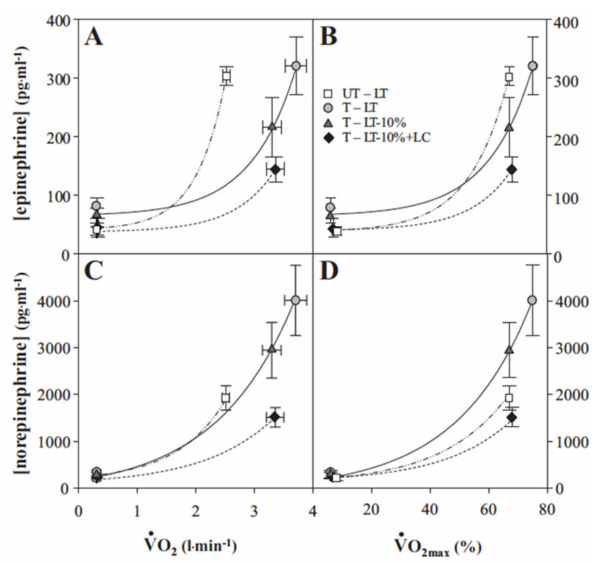
Figure 8. Plasma epinephrine ( A , B ) and norepinephrine ( C , D ) as functions exercise intensity as given by absolute (VO 2 ) ( A , C ) and relative (to % VO 2 peak) ( B , D ). Untrained subjects (UT) were studied at the exercise power output that elicited the lactate threshold (LT). Trained subjects (T) studied at power outputs that elicited the LT, 10% below the LT (LT-10%), and LT-10% plus exogenous lactate infusion raising blood (lactate) (i.e., lactate clamp, LC) to that eliciting the LT (LT-10% + LC). Metabolic rates elicited at rest and exercise in the present and previous studies involving subjects with different physical fitness status. VO 2 max values (means ± SEM) of UT and T subjects are 3.7 ± 0.1 and 5.0 ± 0.3 L · min − 1 , respectively. Whether expressed as absolute or relative values both trained and untrained subjects respond to increments in exercise intensity with exponential increments in circulating catecholamines. From [21].